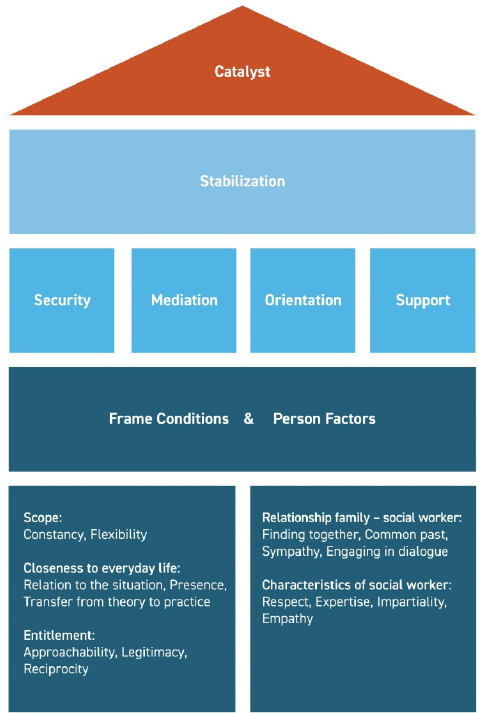
Figure 1. Mechanism concept of PAC (psychosocial aftercare program).